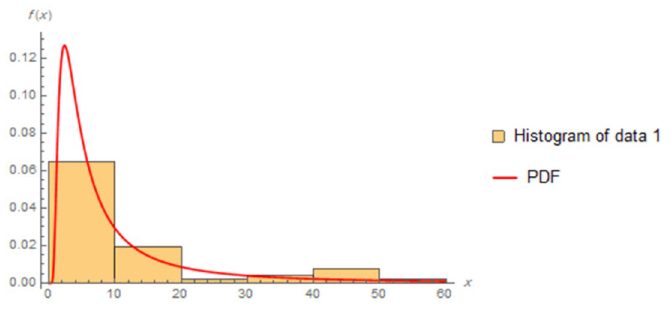
Fig 10. Estimated PDF of data